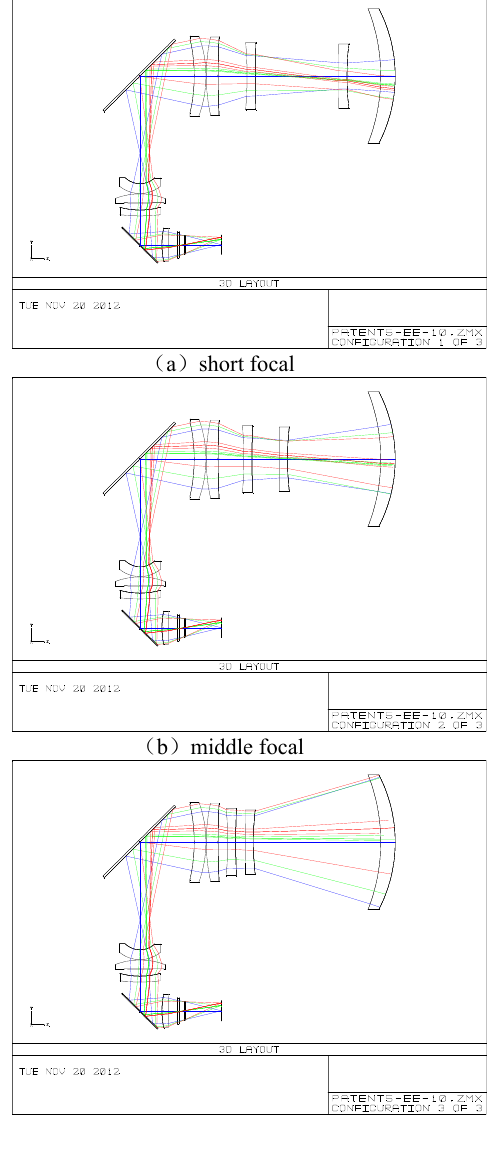
Fig.2 Configuration of zoom optical system throughout the range 4.2 Zoom paths